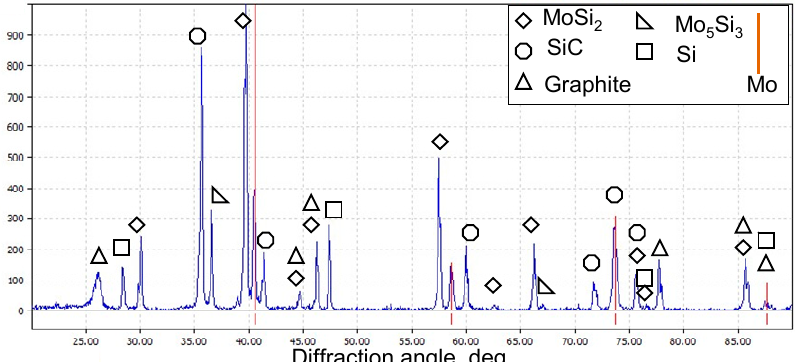
Figure 6. XRD pattern of the SiC-based ceramic with Mo wire. The Mo peaks are marked by the vertical red lines. All other phases are marked by symbols explained in the inset.